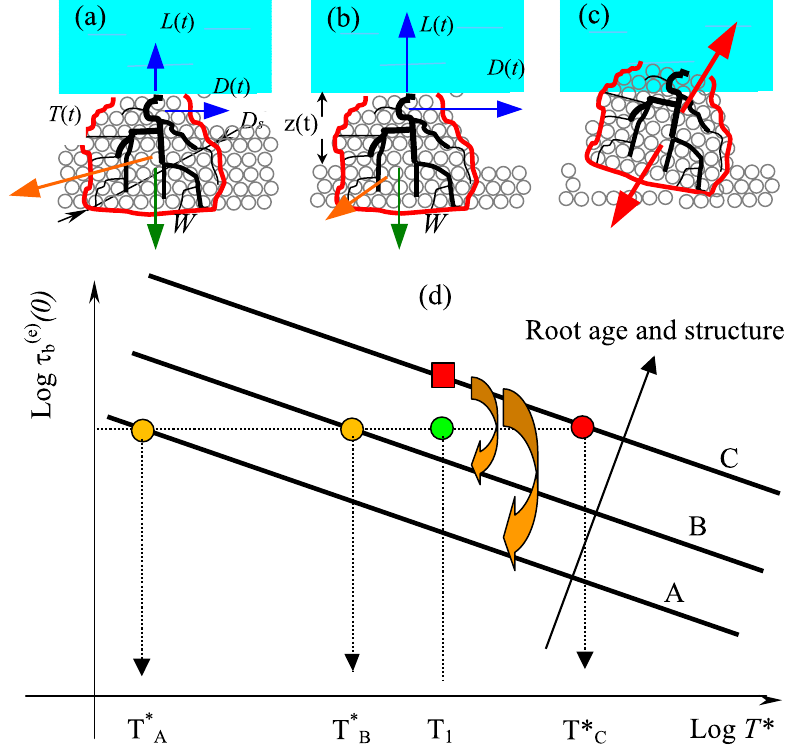
Fig. 4. Conceptual model of Type II root erosion. Subpanels (a) to (c) illustrate the gradual decrease of anchoring by local erosion until uprooting; (d) describes the interaction of flow magnitude (wall shear stress τ b ) and flow duration ( T ) in order to uproot vegetation of certain maturity (curves A–C, A representing the least, C the most mature vegetation). (